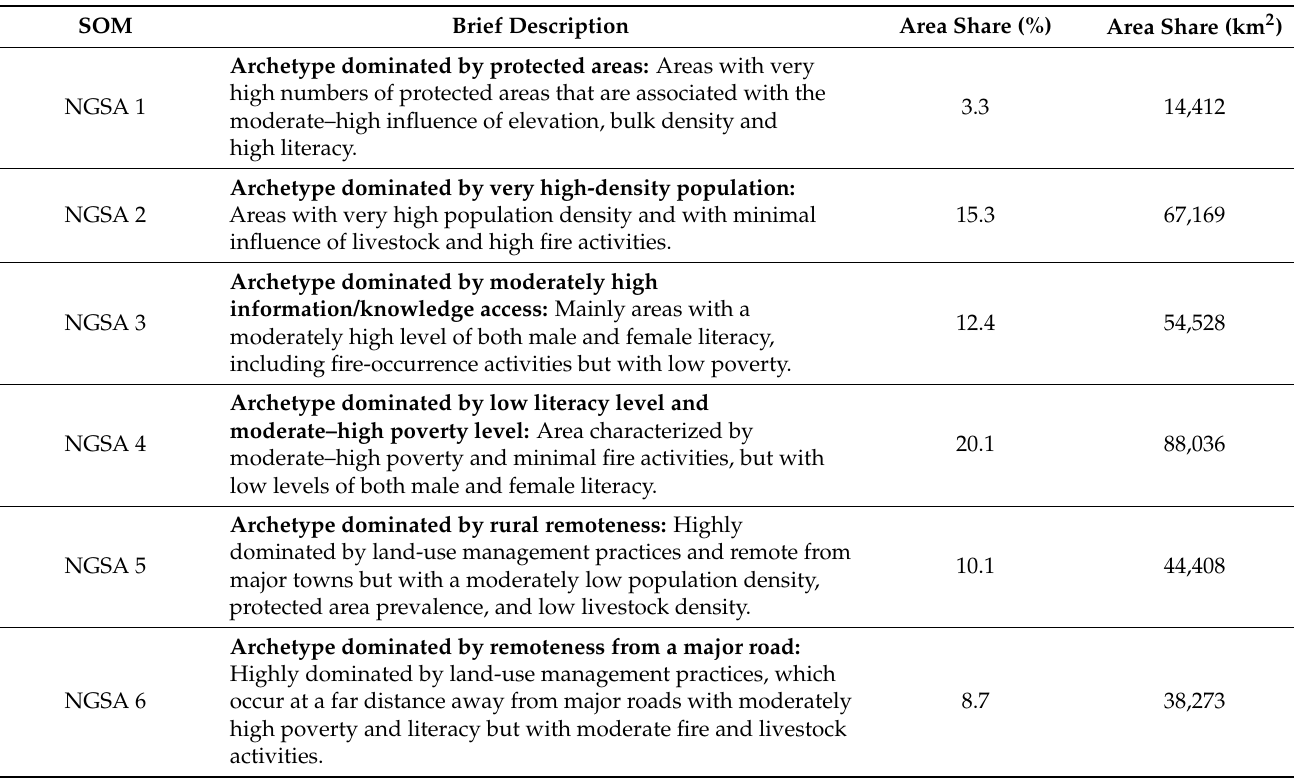
Table 2. Description and share of the archetypes of LD drivers.